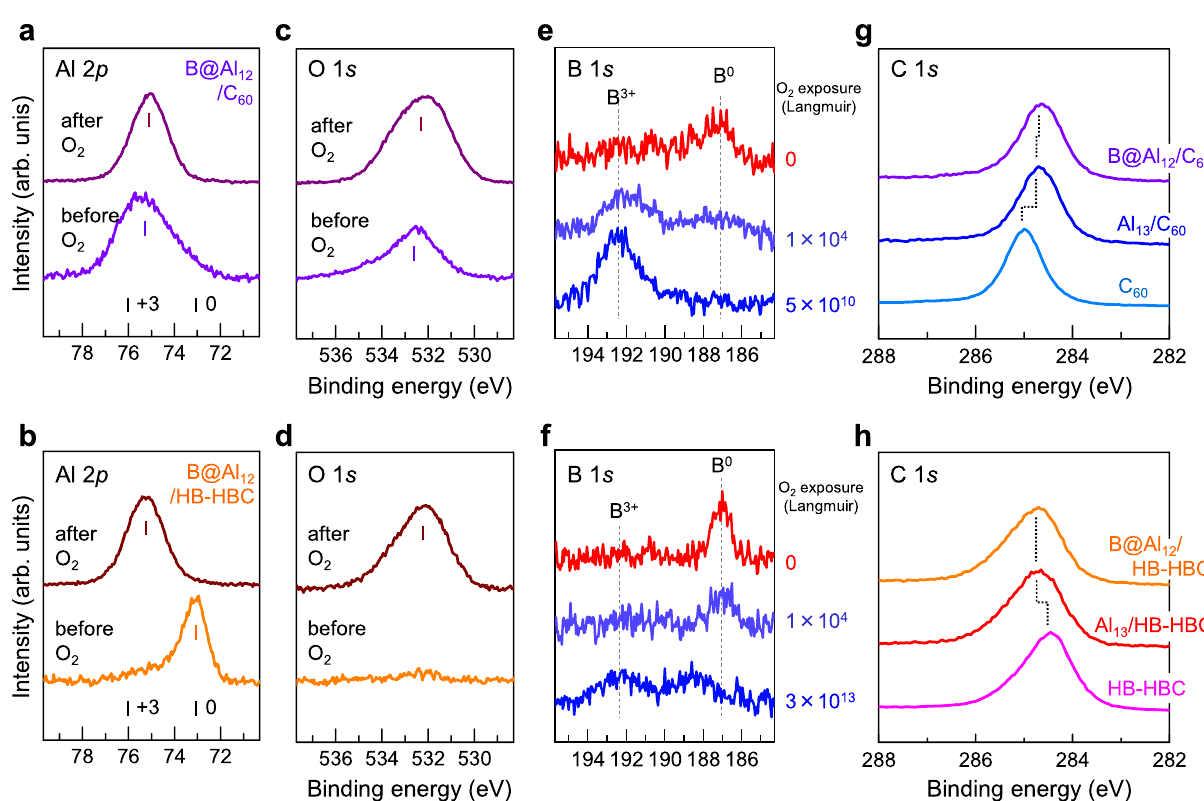
Fig. 4 XPS spectra for B@Al 12 on the C 60 and HB-HBC substrates. a – d XPS spectra around the core Al 2 p levels for a B@Al 12 on C 60 and b B@Al 12 on HB- HBC before (lower) and after (upper) O 2 exposure (at 5 × 10 10 L), along with c , d O 1 s for each state. e , f XPS spectra around the B 1 s core levels for e B@Al 12 on C 60 f B@Al 12 on HB-HBC before (top) and after (lower) O 2 exposure. g , h XPS spectra around the C 1 s core levels of the underlying g C 60 or h HB-HBC are also shown for the depositions of B@Al 12 and Al 13 . The reference binding energies (BEs) of Al 2 p and B 1 s for the bulk Al and B (Al 0 /B 0 and Al 3 + /B 3 + ) and O 1 s (O 2 − ) are marked by vertical bars. The BEs for Al 2 p show the presence of zerovalent Al 0 only for Al 13 on HB-HBC before O 2 exposure, while the other BEs are in the vicinity of Al 3 + , indicating the presence of oxidized Al atoms. After the deposition of 0.6 ML B@Al 12 (violet) and Al 13 (blue) on C 60 , the C 1 s peak in ( g ) shifts by ~0.3 eV toward a lower BE from that before deposition (light blue), showing an anionic C 60 − state. After the deposition of 0.6 ML B@Al 12 (orange) and Al 13 (red) on HB-HBC, the C 1 s peak in ( h ) shifts by ~0.25 eV toward a higher BE than that before deposition (pink), showing a cationic HB-HBC + state. Importantly, with B atom doping, B@Al 12 is stabilized even in the cationic form, as shown by the tailing peak of Al 2 p in ( a ) and the non-oxidized B 0 component in ( e